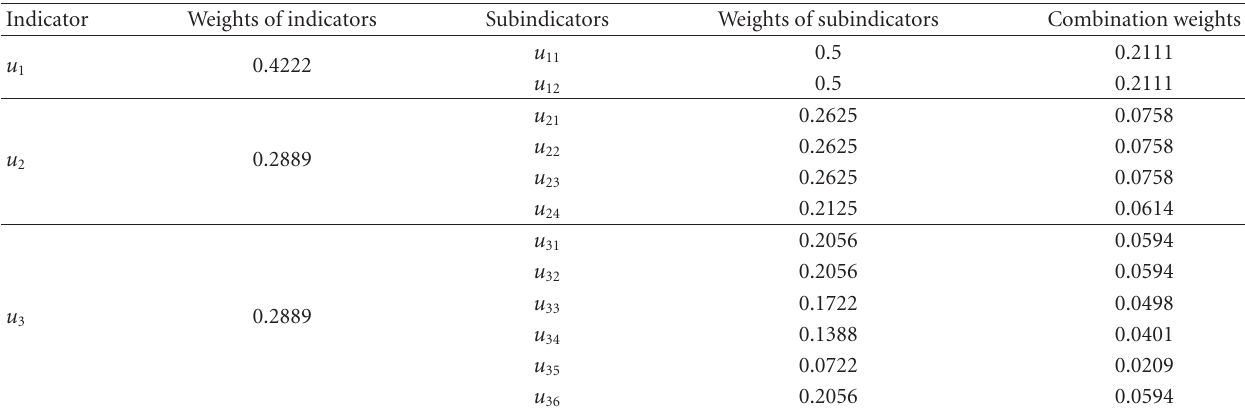
Table 5: The weights of all the indicators.